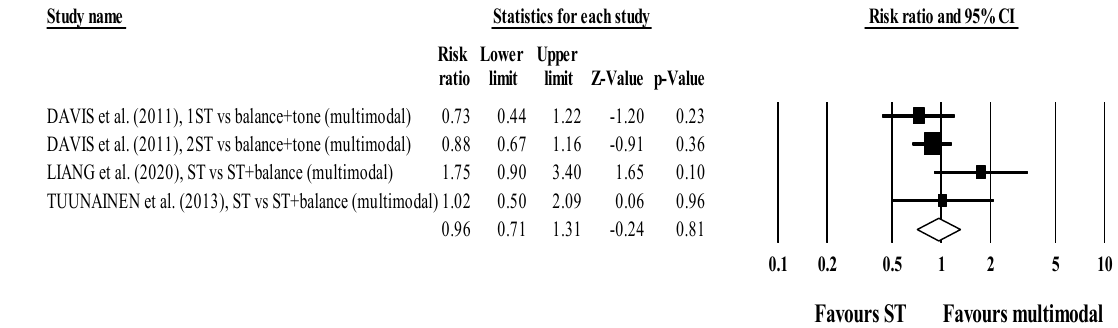
Figure 3. Forest plot for risk of falling after participating in ST programs compared to unimodal active/passive control conditions.